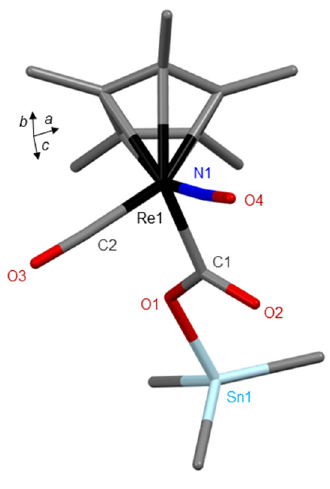
Figure 23. Molecular structure of 23 , adapted from [77] (MERCURY view). Hydrogen atoms and one molecule of CHCl 3 are omitted for clarity (Sn light blue, O red, N blue, Re black, C grey). In 1997, two new specimen of CO 2 -bridged rhenium/tin complexes were character- ized at the solid-state by the Gibson’s group [78]. The transmetalation reaction